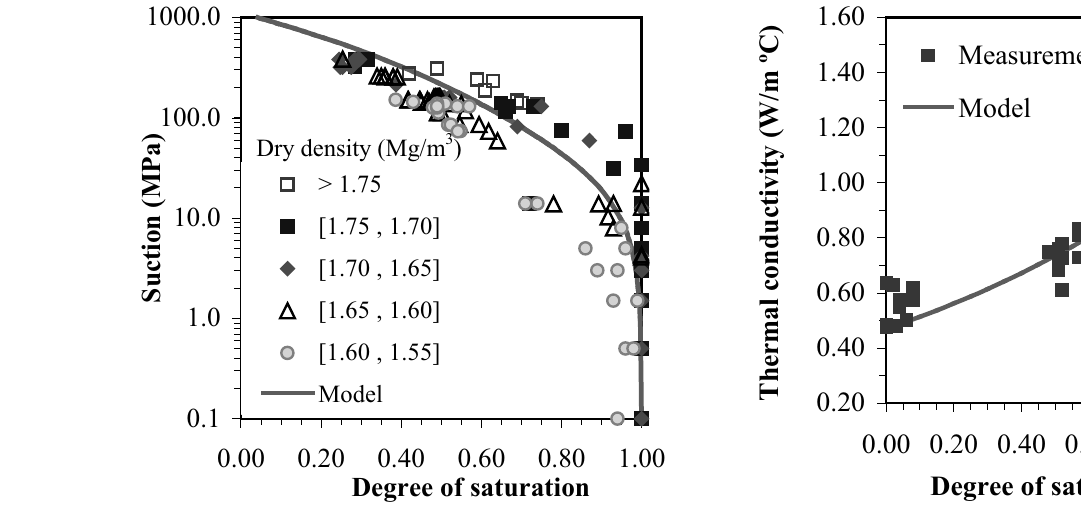
Fig. 4 – Retention curve adopted in the analyses, together with the experimental data for FEBEX bentonite (symbols).